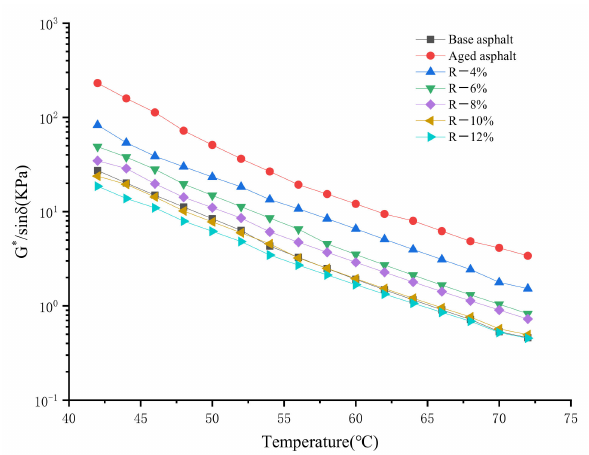
Figure 3. Test results of rutting factor ( G ∗ / sin δ